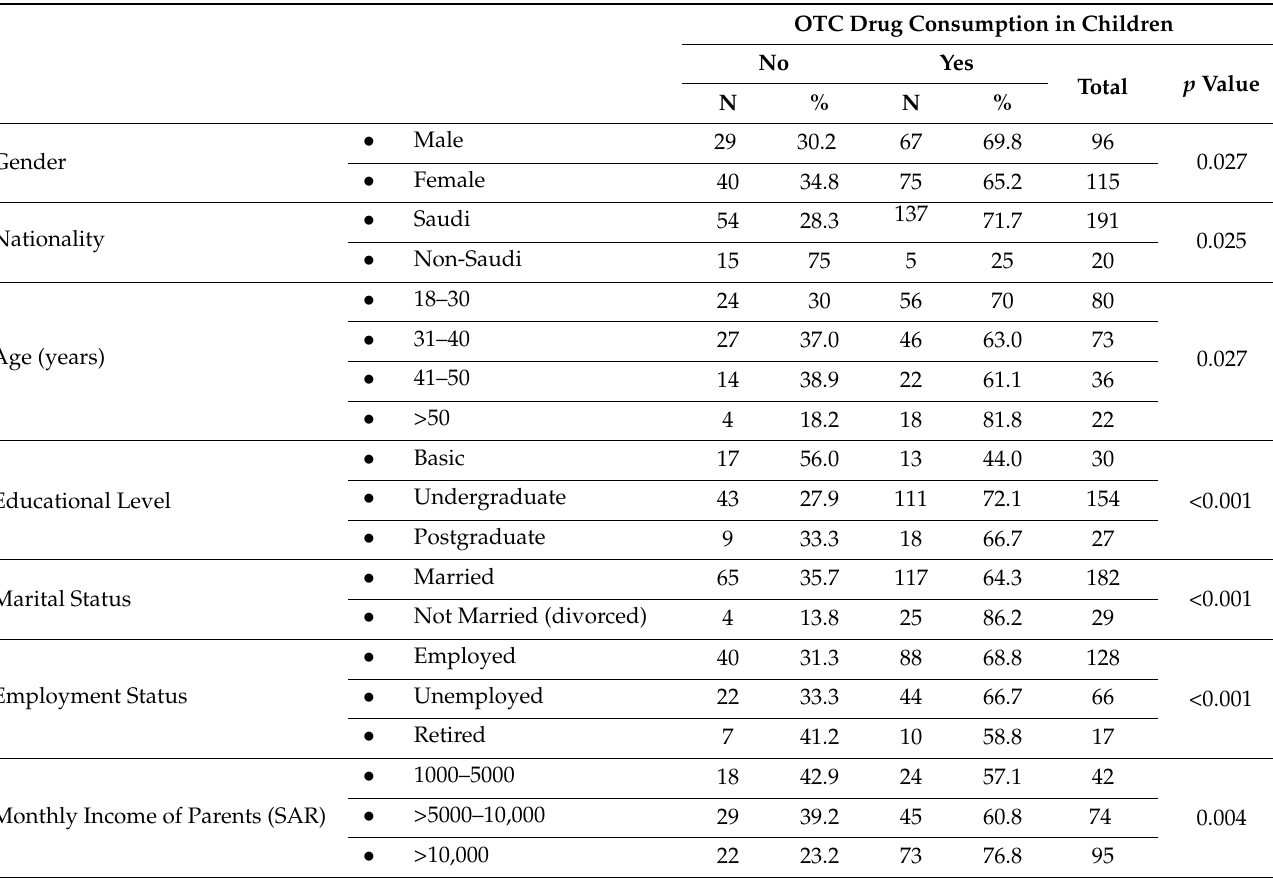
Table 2. The relationship between [1] sociodemographic characteristics and [2] OTC drug consump- tion in children. Statistical significance was determined at a p -value of